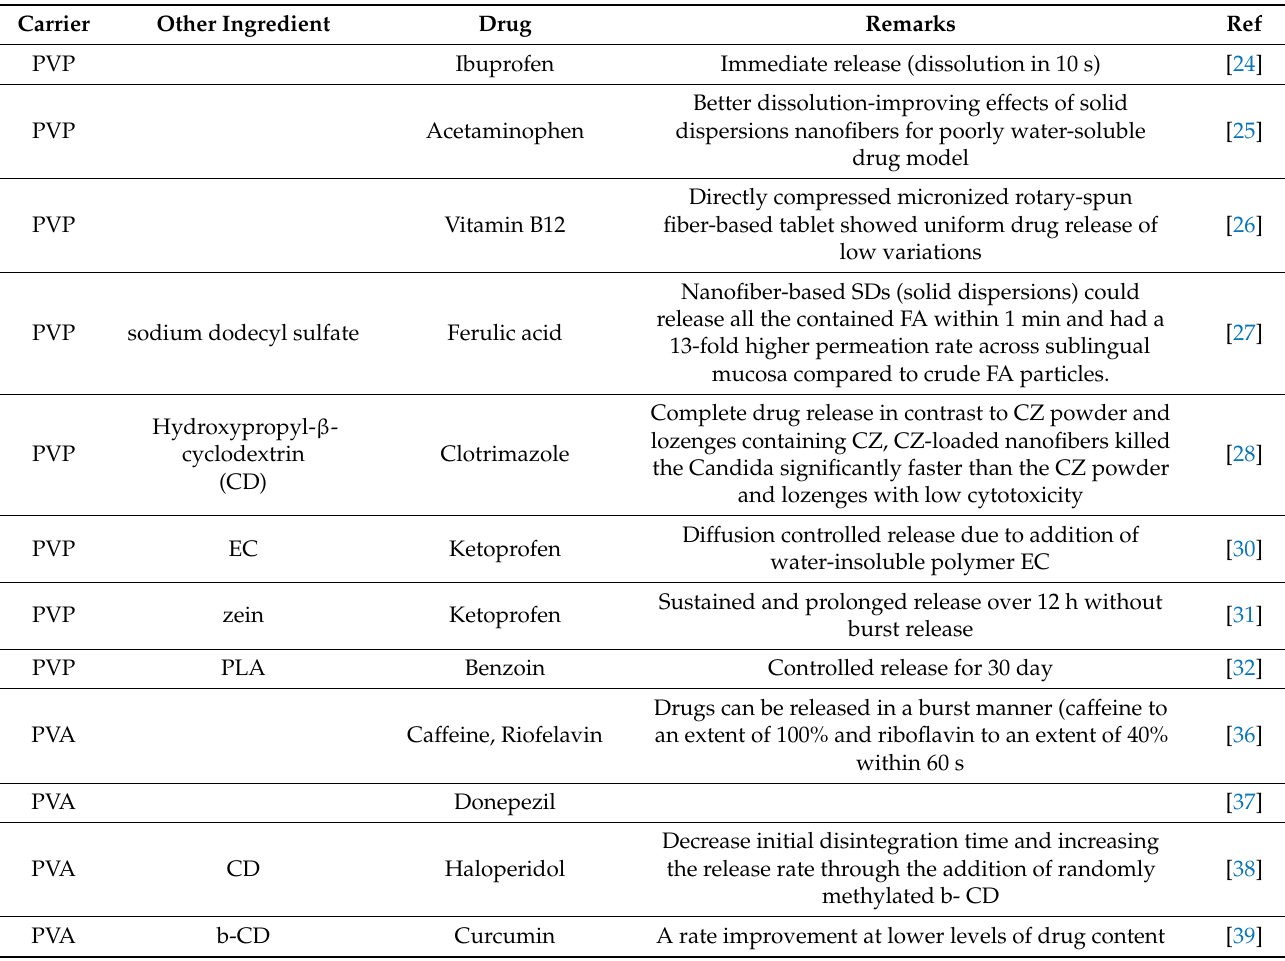
Table 1. Electrospun poly(vinyl alcohol) (PVA) and poly(vinyl pyrrolidone) (PVP) nanofibers for drug-delivery application. Carrier Other